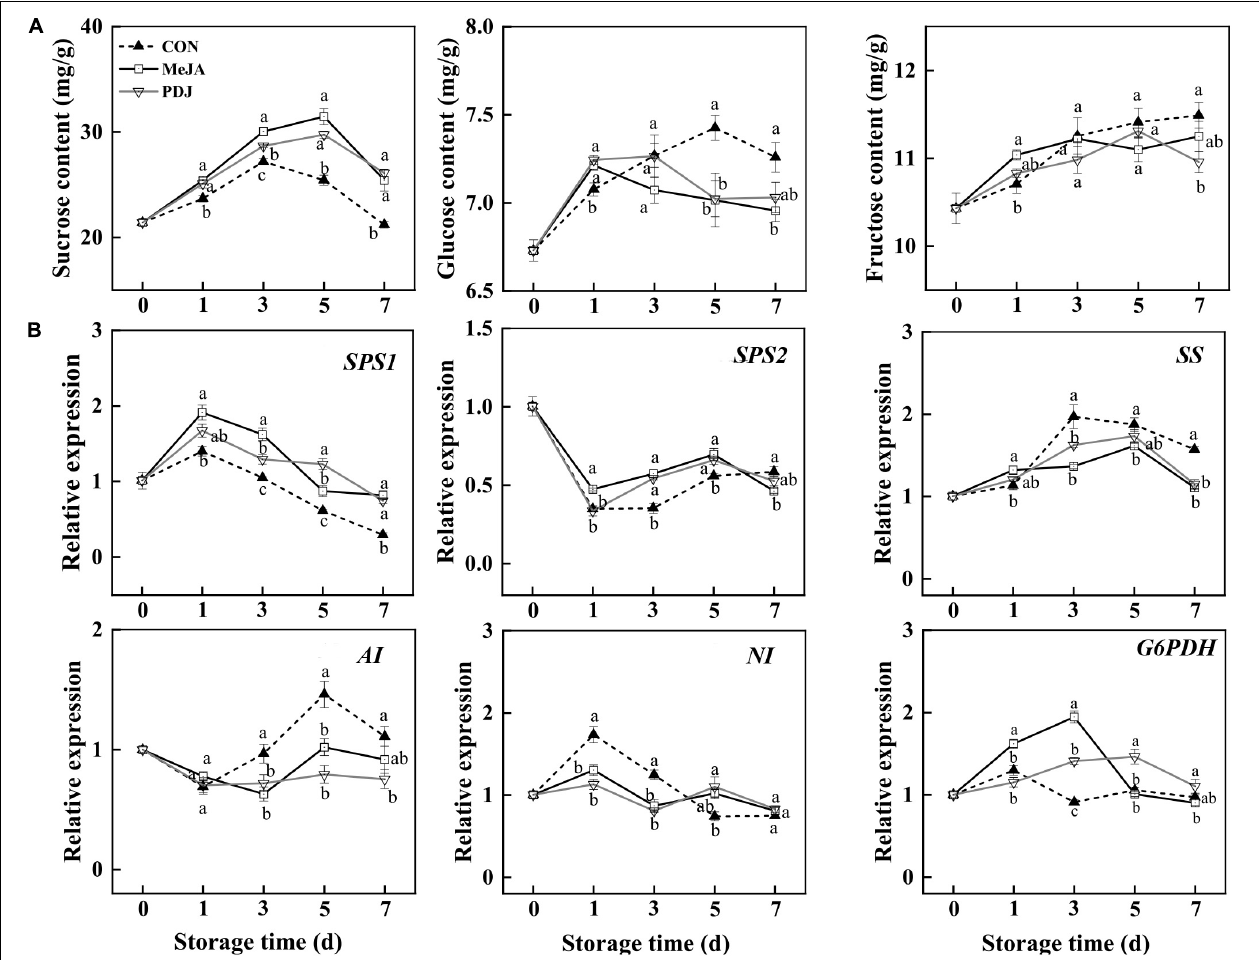
FIGURE 6 | Effects of postharvest jasmonate treatments on sugar contents and the expressions of associated genes during storage (22 ± 2 ◦ C; light intensity 300–400 lux; different lower-case letters indicate significant differences ( P < 0.05) from three treatments at the same time point): (A) Sucrose, glucose and fructose contents; (B) expressions of genes in the sucrose metabolism